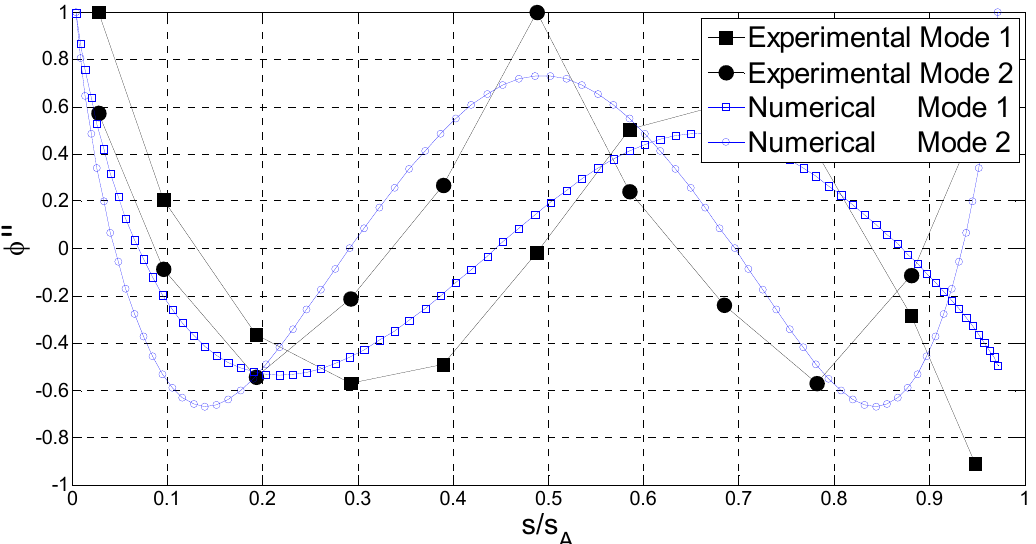
Figure 2: Curvature mode